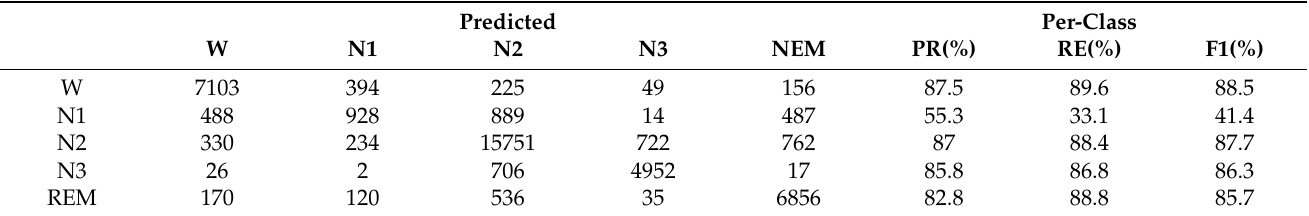
Table 2. Confusion matrix and per-class metrics of applying Siamese CNNs to the baseline sleep staging model on the SleepEDF dataset using 20-fold cross-validation.